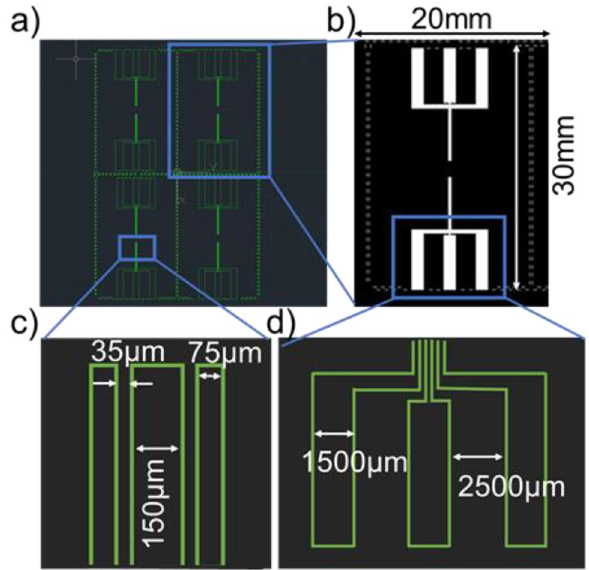
Figure 1. Design M: ( a ) 4 × 4 inches microelectrodes photomask layout on AutoCAD, ( b ) Isolated microelectrode for single biochip, ( c ) Coplanar electrodes dimensions and the gap between them, ( d ) Extended electrodes area dimensions for soldering on PCB or external setup.